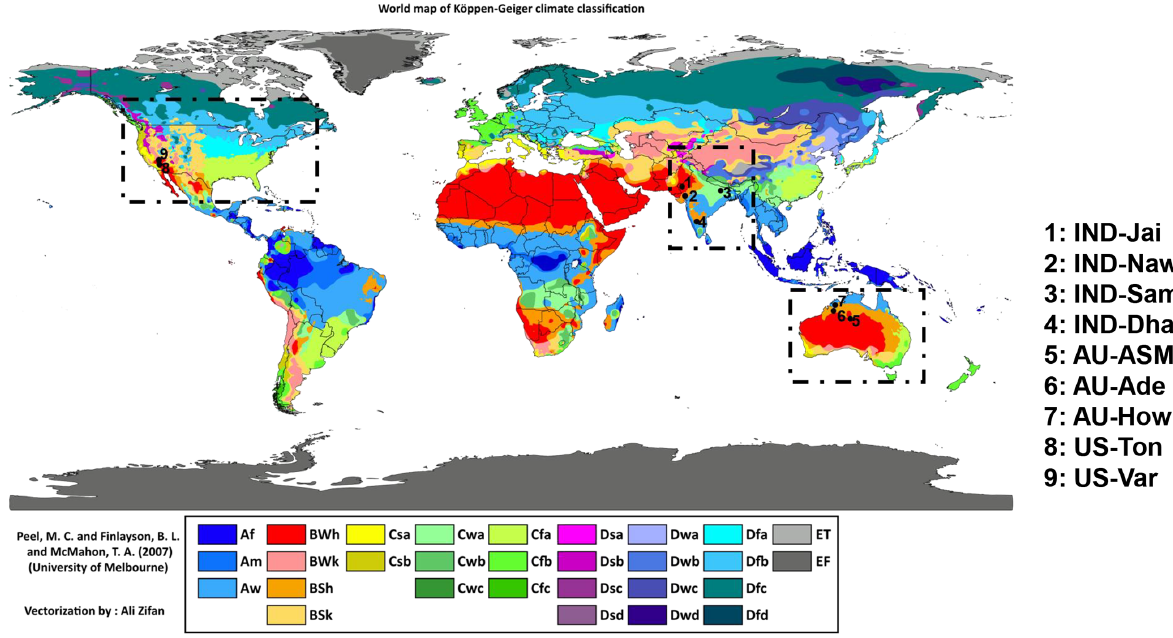
Figure 1. Locations of the flux tower sites in India, Australia, and the USA overlaid on a climate-type map. Image source: Peel et al. (2017).